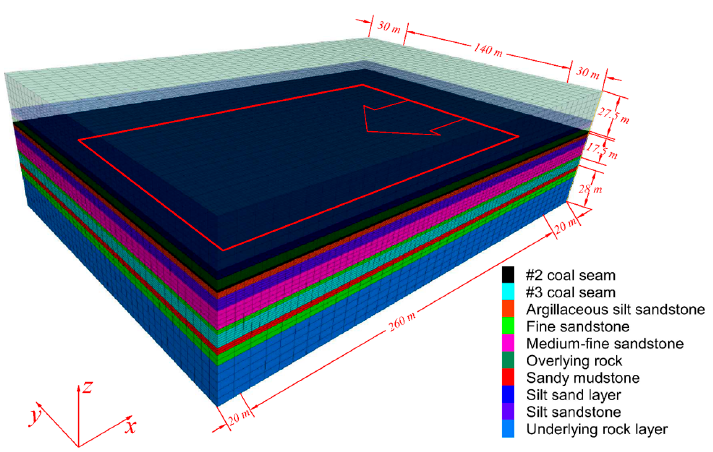
Figure 6. Numerical simulation model.